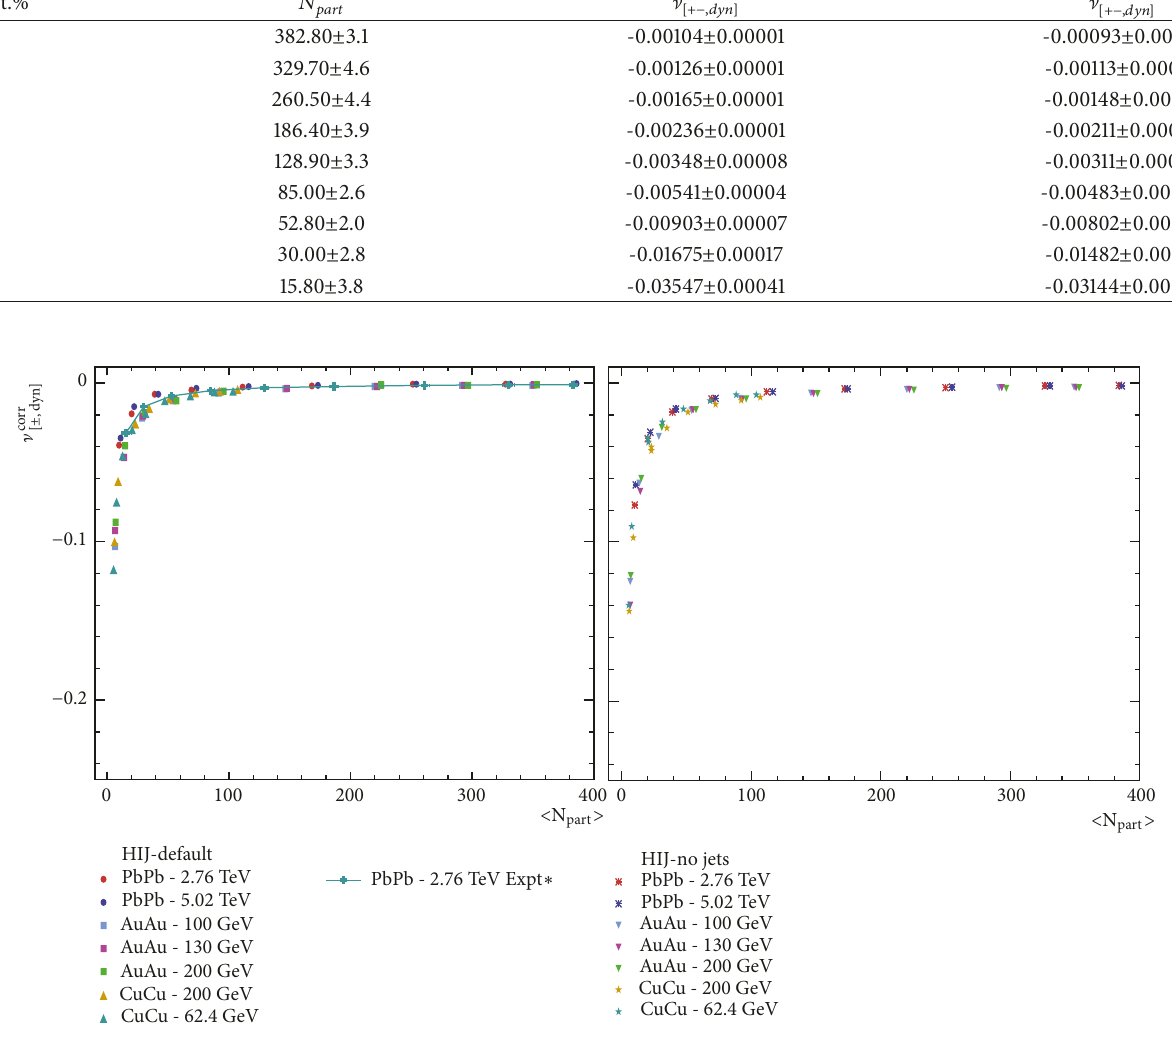
Figure 2: The same plot as Figure 1 but for corrected versions of net charge